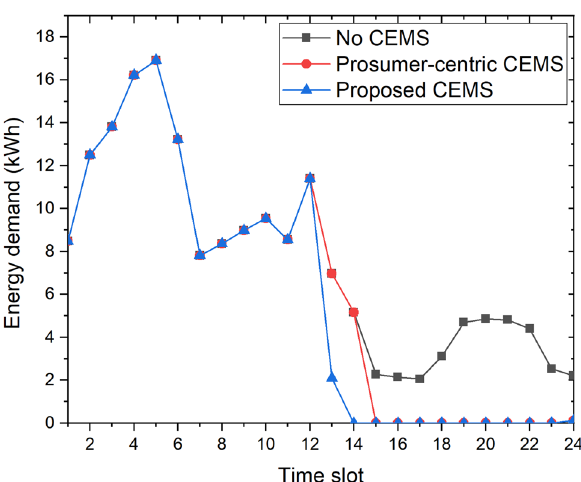
Figure 8. Energy demand of community from the EP with three CEMSs from